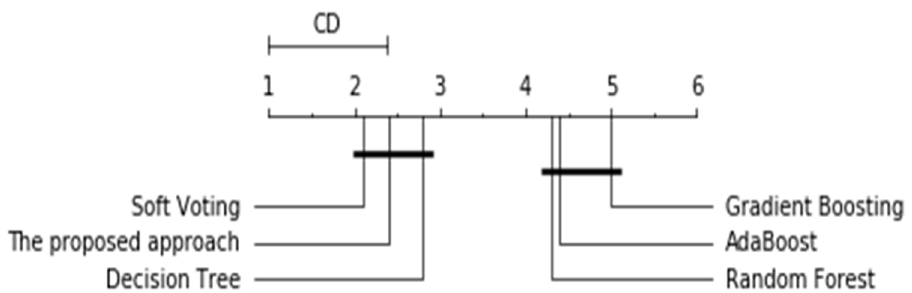
Figure 6. Critical difference diagram for the Nemenyi test.